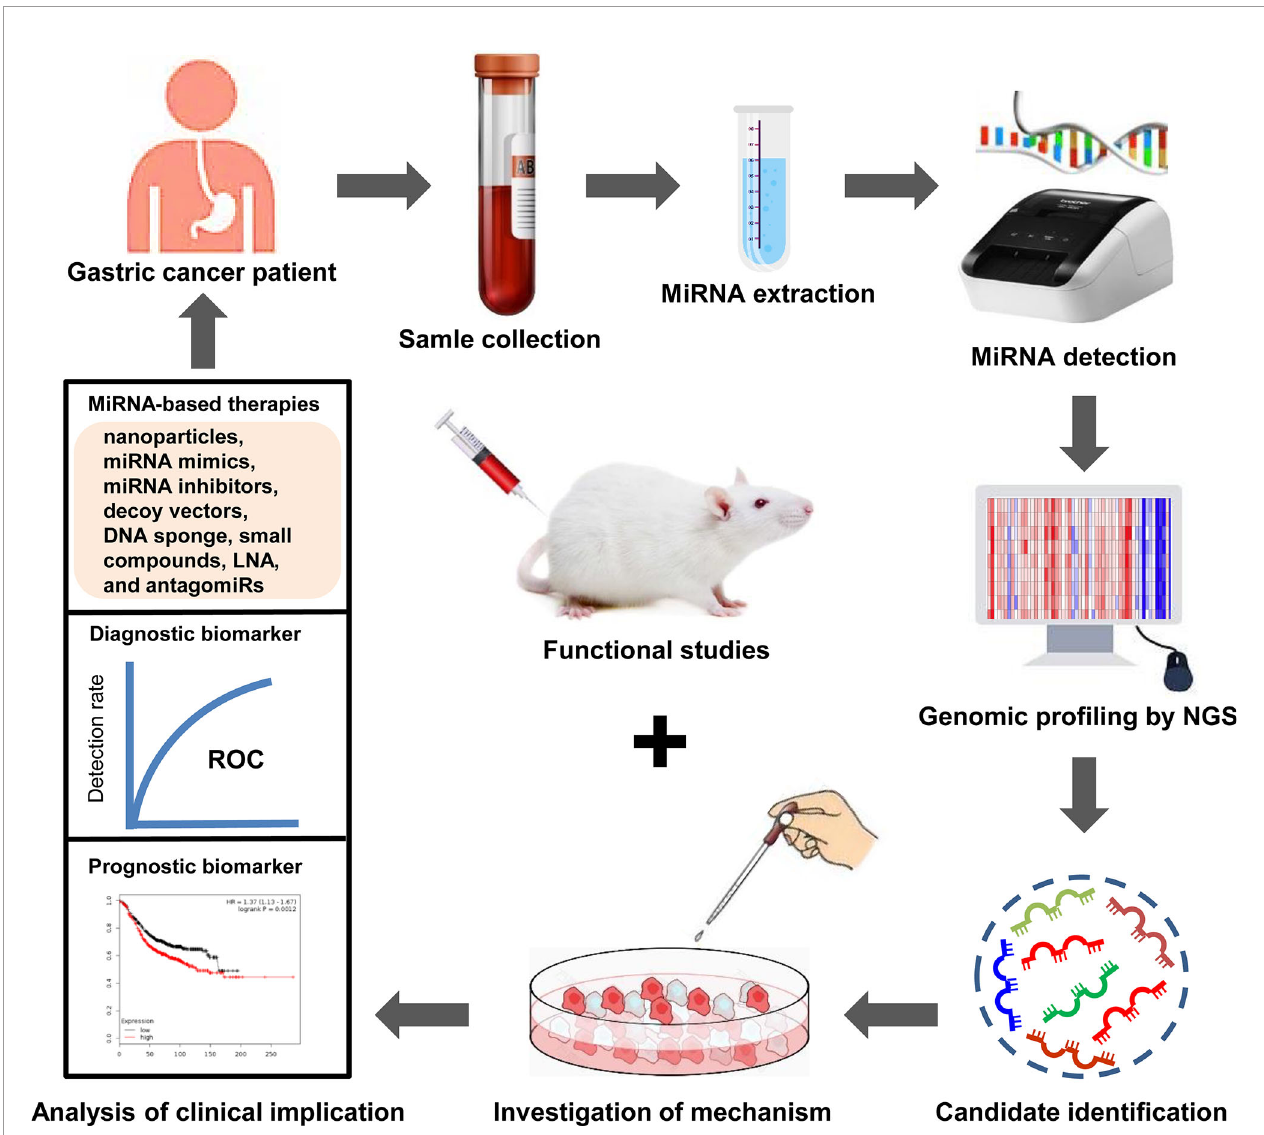
FIGURE 3 | Clinical implications of miRNAs in GC drug resistance. MiRNAs are enriched in blood samples from drug resistant-GC patients. Dysregulated miRNAs are identi fi ed through high-throughput sequencing. Subsequently, the mechanisms of dysregulated miRNA in the drug resistance of GC are investigated using cell models. The functions of dysregulated miRNA in GC drug resistance are investigated using animal models. Next, the dysregulated miRNAs that can act as diagnostic or prognostic biomarkers for drug resistant-GC patients are selected. Moreover, targeting speci fi c miRNAs may produce reliable therapeutic effect. Finally, GC patients with drug resistance receive individualized precision treatment based on these effective